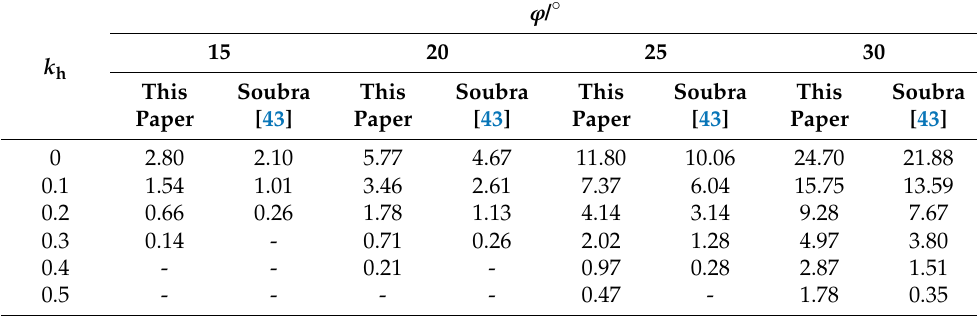
Table 4. Values of seismic bearing capacity factor N p e .